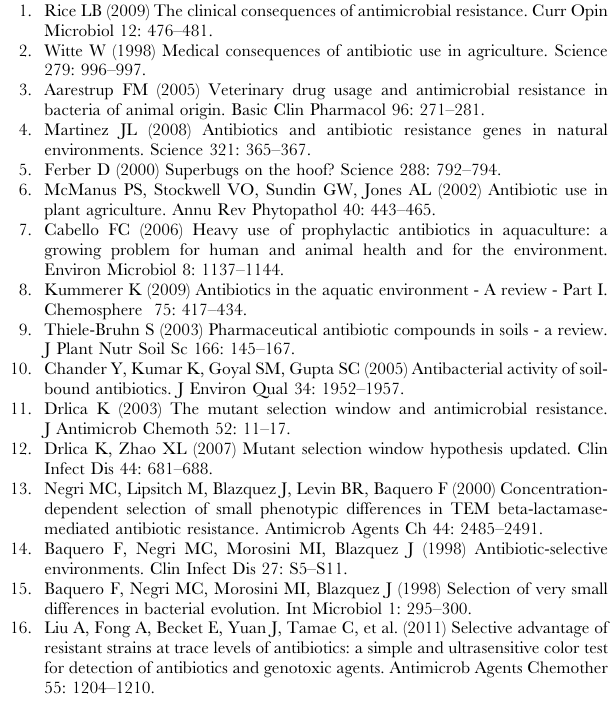
Table S2 (exponential growth rate data), Table S3 (competition data) and Appendix (fixation time for an adaptive